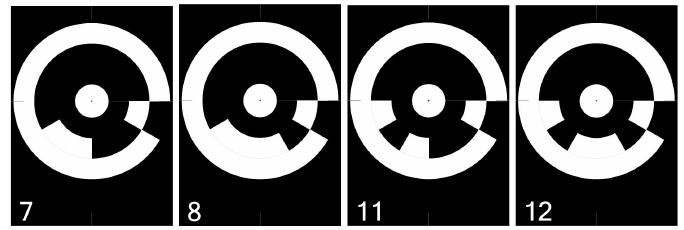
Figure 13. Ground targets for trajectory estimation using photogrammetry.